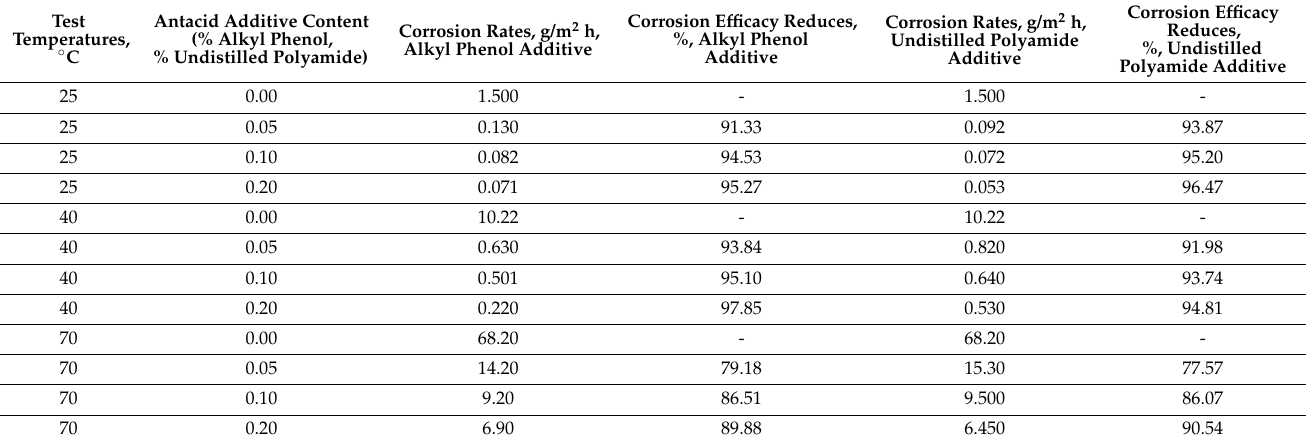
Table 7. Corrosion rate determined on samples collected from the material of the distillation column (OL37), introduced in a bath with HCl in proportion of